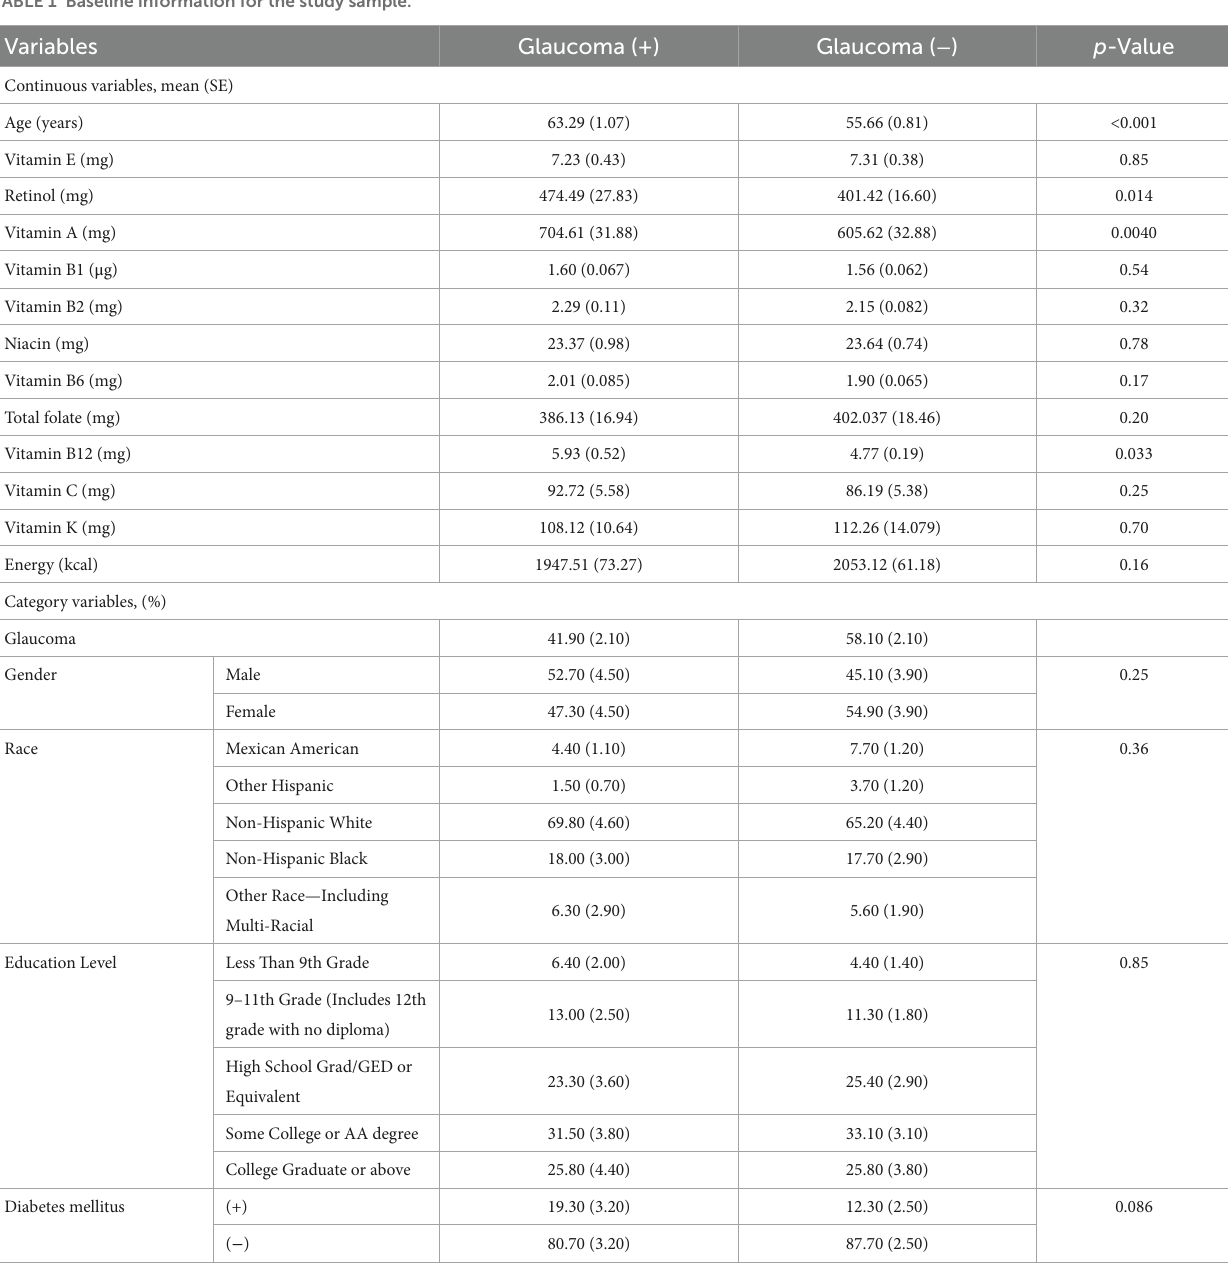
TABLE 1 Baseline information for the study